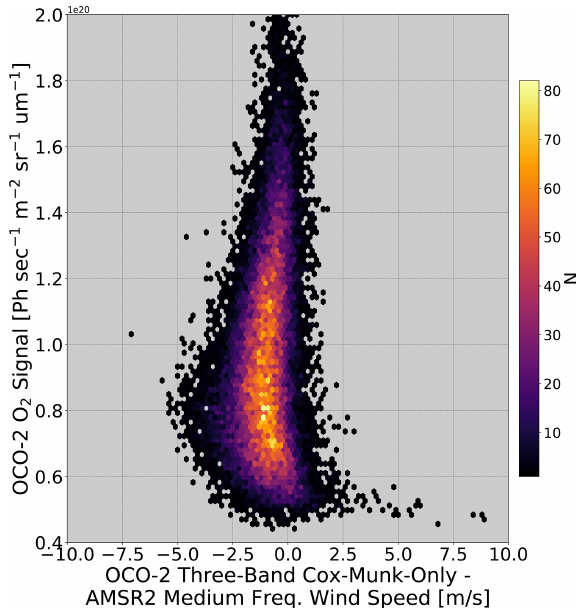
Figure 5. Heatmap of OCO-2 O 2 A-band signal compared to wind speed difference (OCO-2 three-band Cox–Munk only – AMSR2 medium